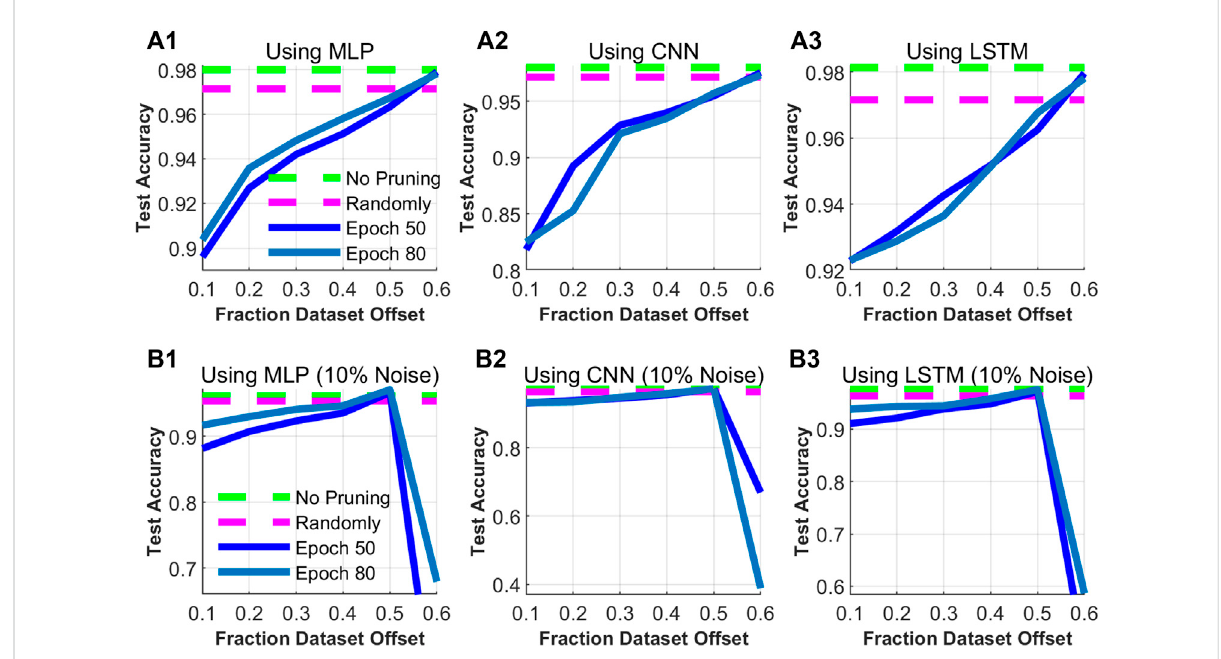
FIGURE 7 Test accuracy of MLP, CNN, and LSTM trained on the full dataset (No pruning) and a 40% subset pruned randomly or bySSI calculated at epoch 50orepoch80.When usingSSI,thesamplewindowslidesalongthesamplesintheascendingorderofSSI.Trainingofthe fi rstrow (A1 – A3) usesthe original dataset. In the second row (B1 – B3) , the dataset contains 10% randomized labels.